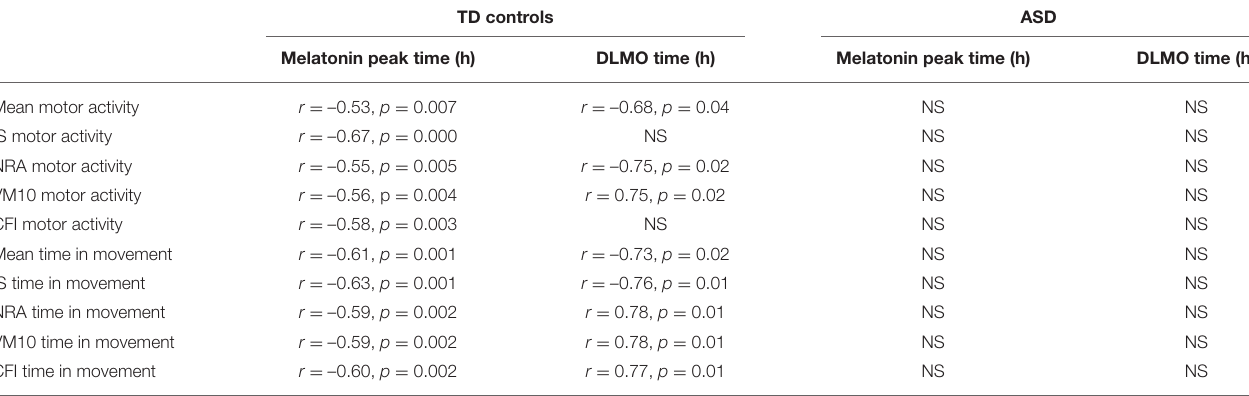
TABLE 6 | Melatonin and motor activity